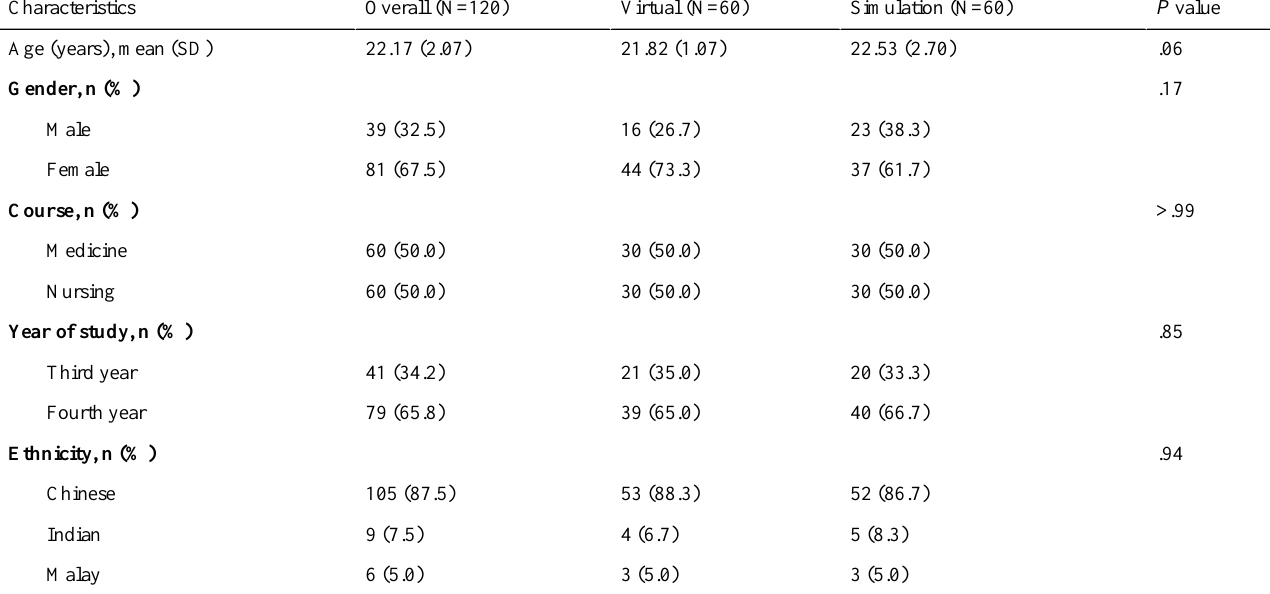
Table 2. Demographic characteristics.